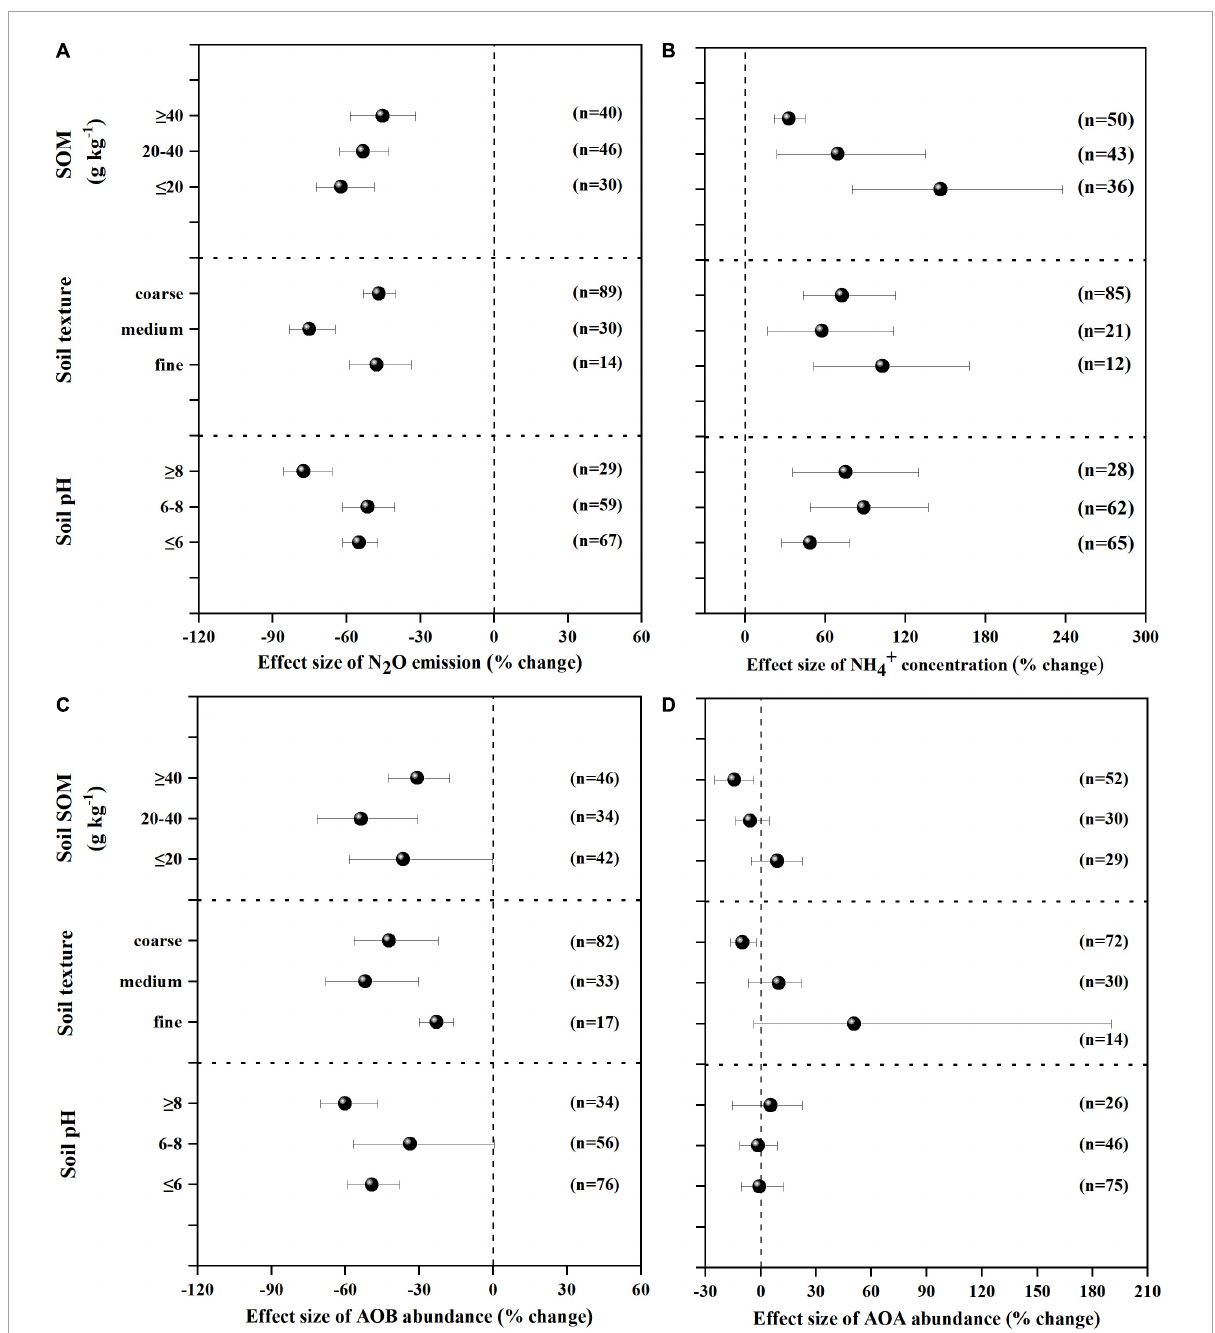
FIGURE2 Mean response ratios (% change) and bootstrapped 95% Confidence Intervals (CI) for the effects of soil properties on the N 2 O emissions (A) , NH + 4 concentration (B) , AOB gene abundance (C) and AOA gene abundance (D) after NIs application. Values in parentheses represent the number of